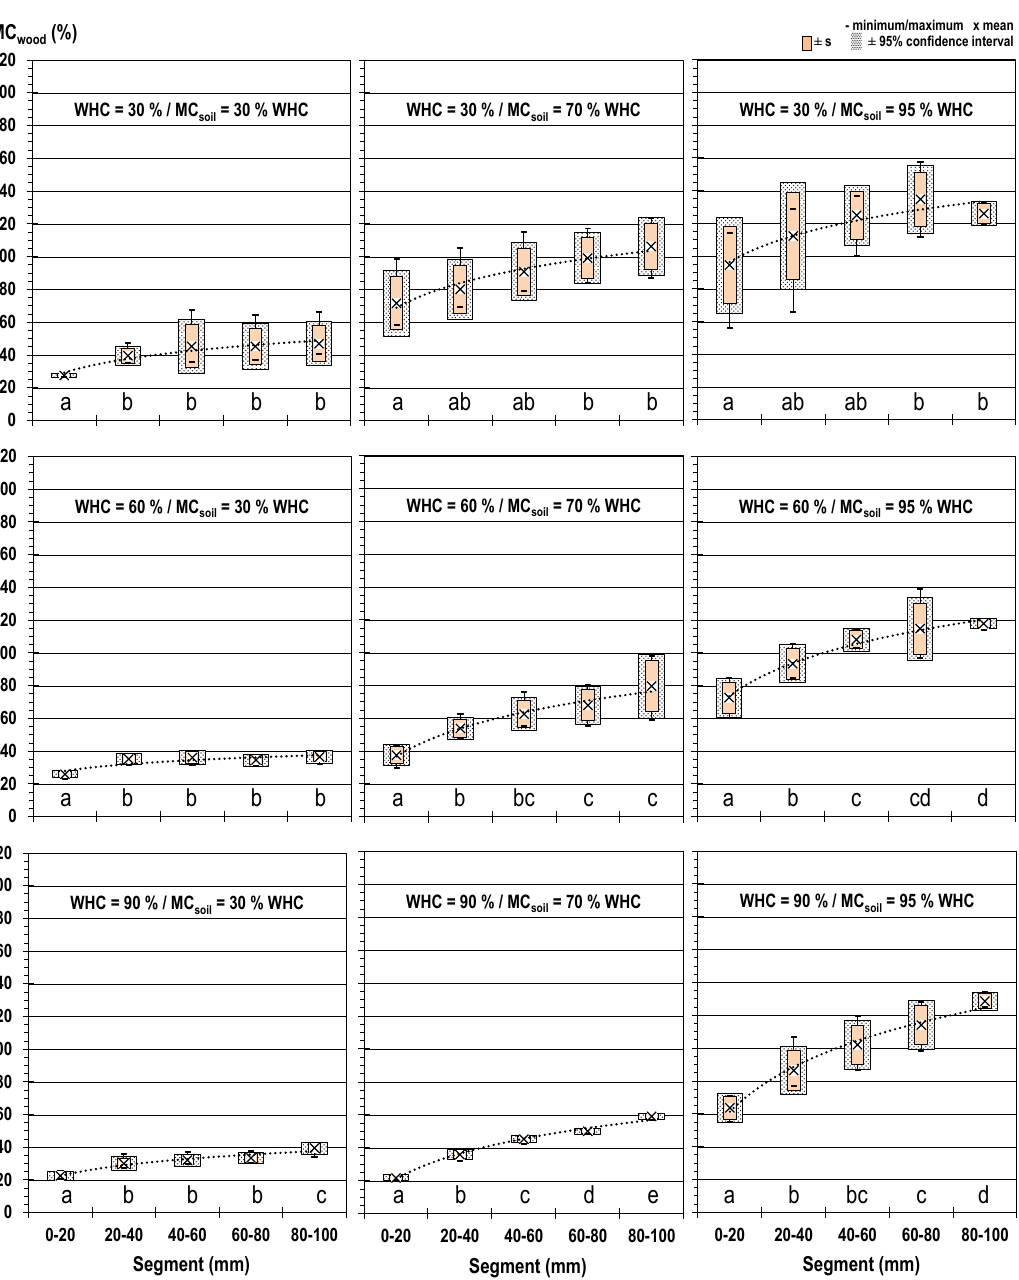
Figure 7. Distribution of MC wood in Beech specimens buried to 4 / 5 of their length (20–100 mm) in different TMCs. Different letters indicating significant differences between groups at p < 5% according to a Student t -test for non-paired samples.